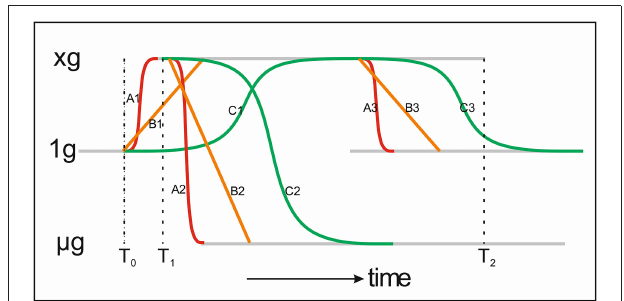
FIGURE 4 | This is a cartoon illustrating gravity levels (gray lines) and (biological) systems response times. Fast responding systems (red line, A1–A3), linearly somewhat intermediate responding systems (orange line, B1–B3) and slow responding systems (green line, C1–C3). When a sample is launched is goes from 1g to × g, delta y, for a fast responding systems going through A1. When going into free fall after launch the fast system would follow A2, delta y + delta x. In this representation the times for both fast and slow responding systems regarding a Reduced Gravity Paradigm are set properly.